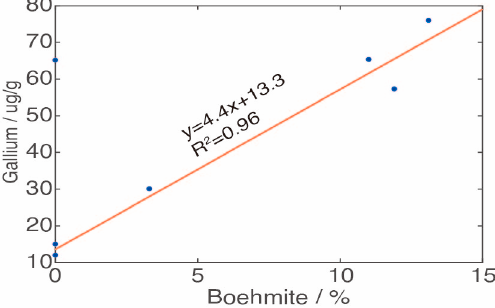
Figure 3. Cross plots of boehmite vs. gallium contents for cores.